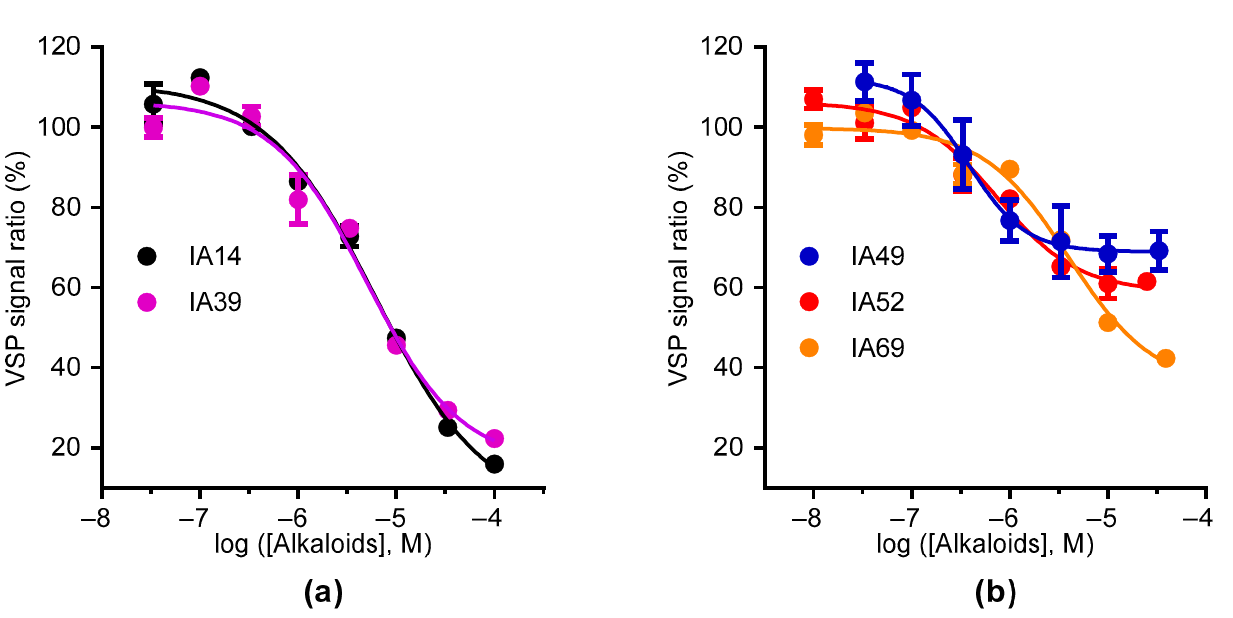
Figure 5. Concentration–inhibition curves of oxostephanine, liriodenine, thalmiculine, bebeerine, and protopine for the BTX-induced VSP FRET signal in GH3b6 cells. ( a ) Concentration–inhibition responses of the BTX-induced VSP signal to increasing concentrations of oxostephanine (IA14) and liriodenine (IA39). ( b ) Concentration–inhibition responses of the BTX-induced VSP signal to increasing concentrations of thalmiculine (IA49), bebeerine (IA52), and protopine (IA69). The data were best fitted by non-linear regression to the Langmuir–Hill equation with a variable slope and are shown in Table 2. Data are mean (± SEM) and representative of two independent experiments ( n = 6). Table 2. Curve fitting parameters of the concentration–inhibition relationships of oxostephanine, liriodenine, thalmiculine, bebeerine, and protopine.